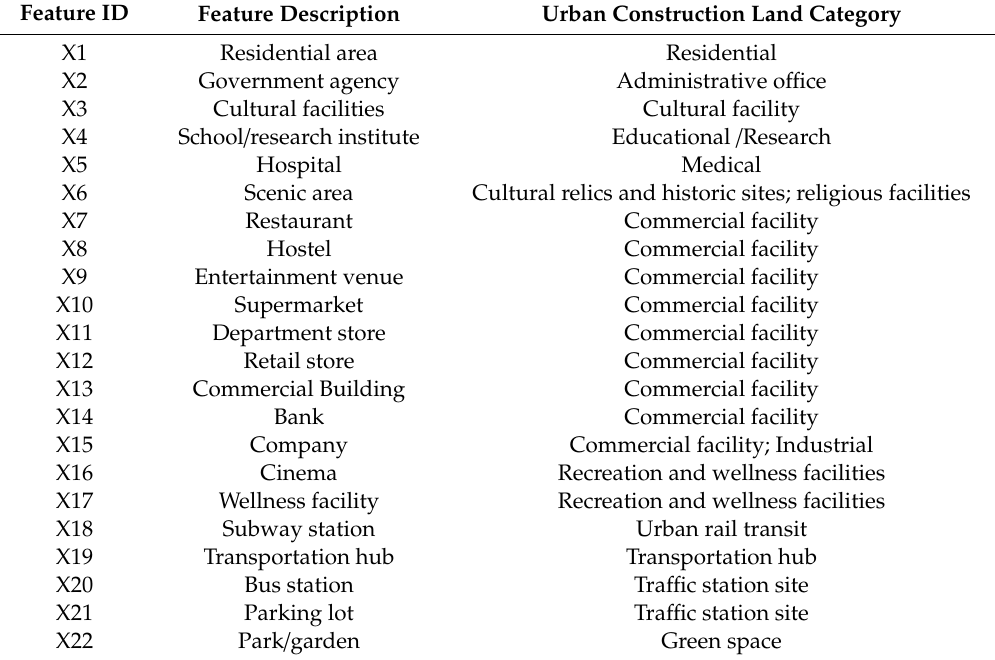
Table 1. POI feature set and land use